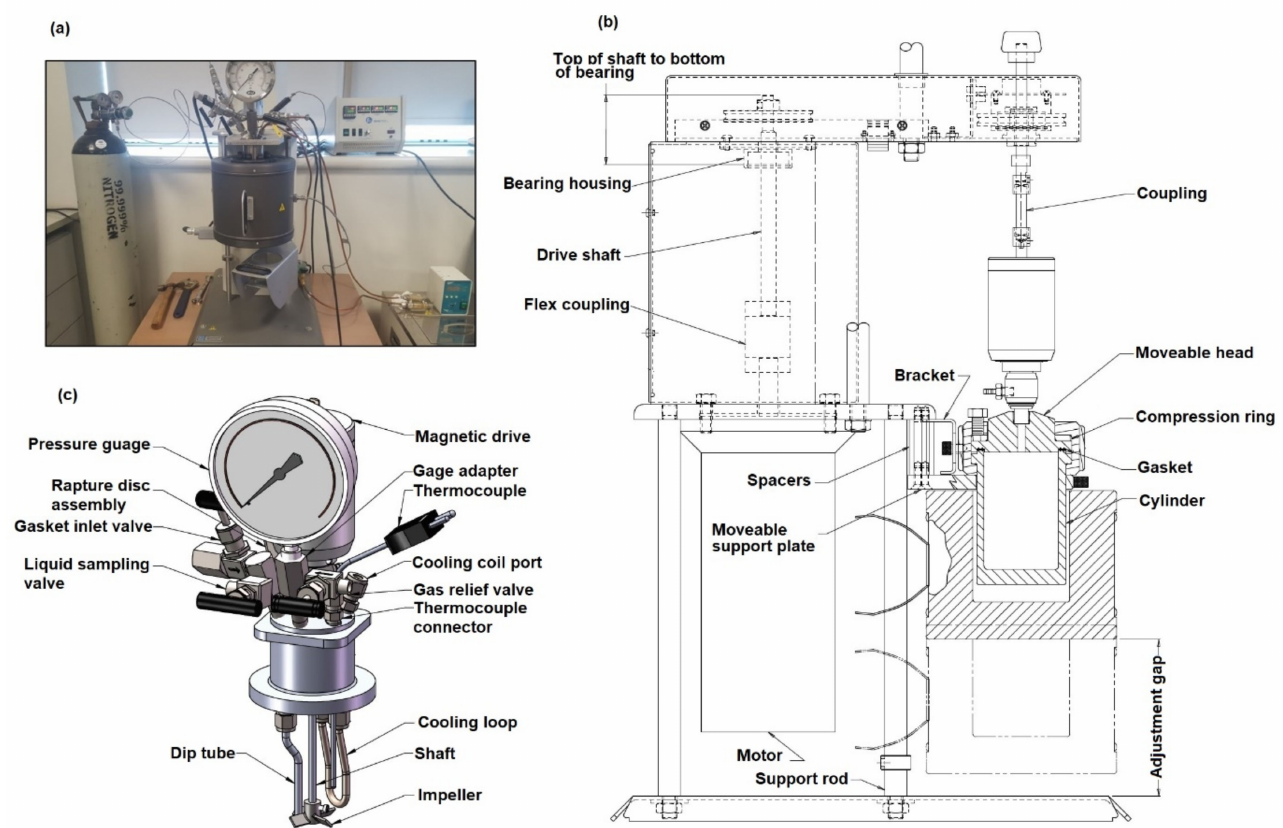
Figure 14. The high-pressure, high-temperature reactor ( a ) pictorial diagram, ( b ) assembly drawing, and ( c ) fixed